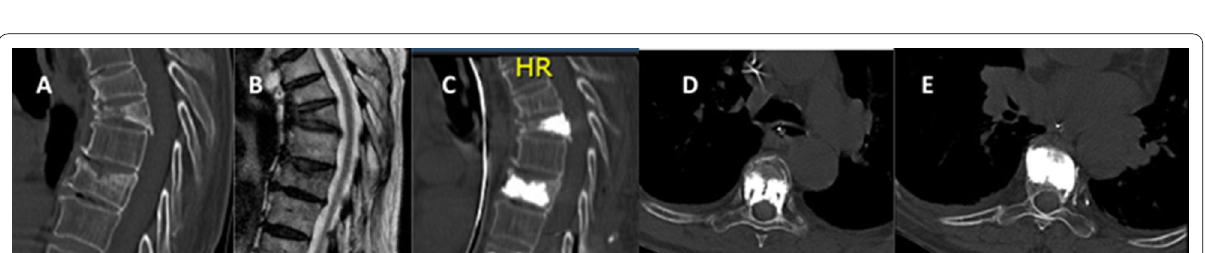
Fig. 4 A , B Sagittal CT and MRI of osteoporotic thoracic vertebral fractures (T4 and T6); T4: OF type 3, T6: OF type 2. C – E CT scan (sagittal and axial) after PVP of both vertebral fractures without